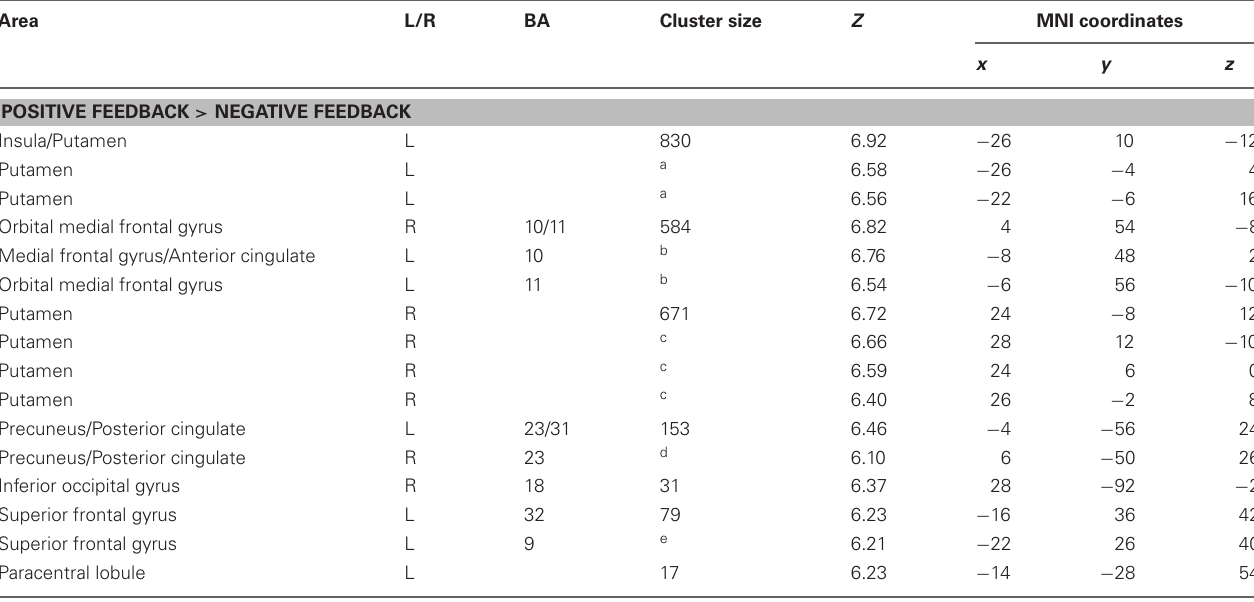
Table 1 | Whole brain analysis for the contrast positive feedback—negative feedback.